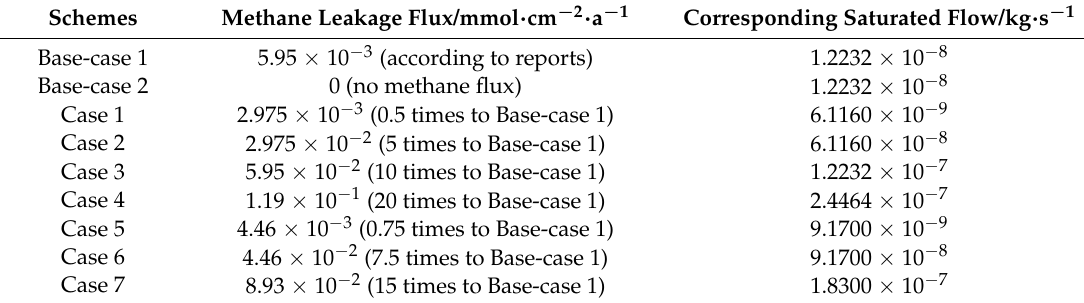
Table 5. Design of simulated